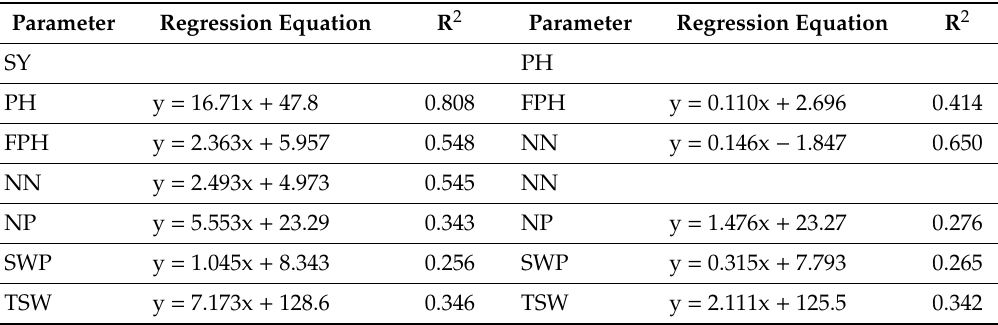
Table 4. Regression analysis between some